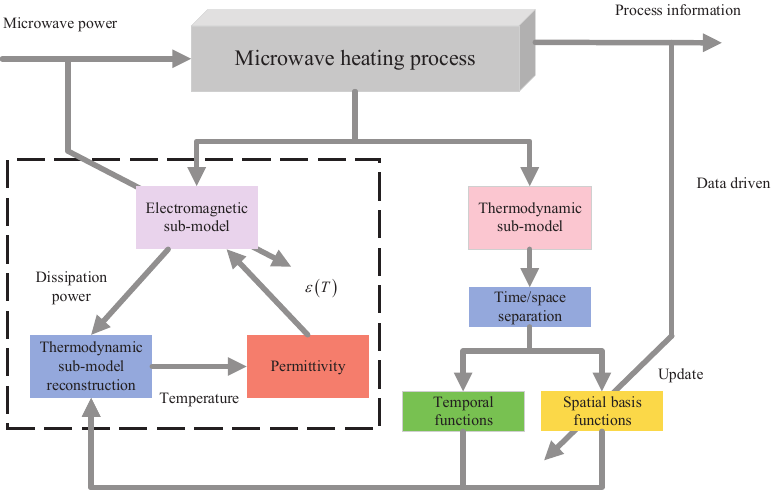
Figure 1. General framework of data-driven based spatiotemporal model